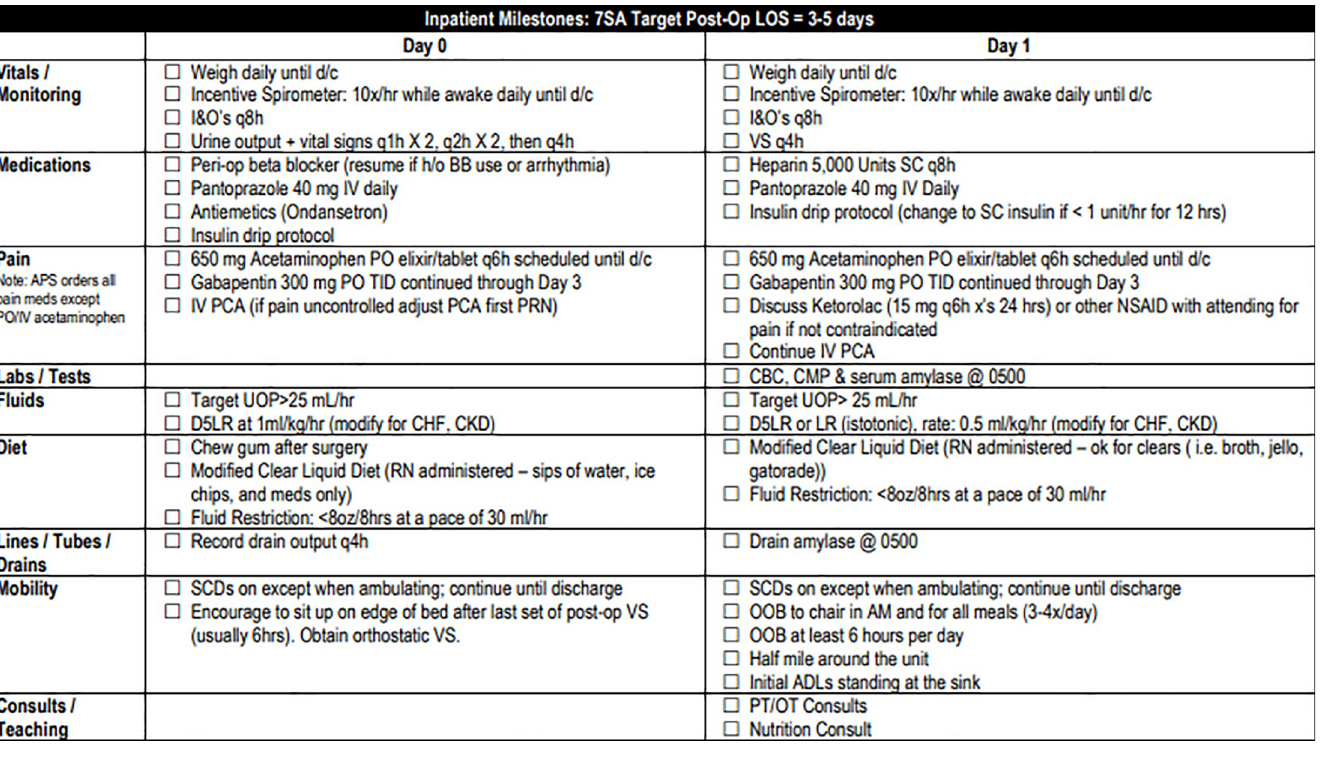
Fig 3. Whipple Post-operative Pathway Days